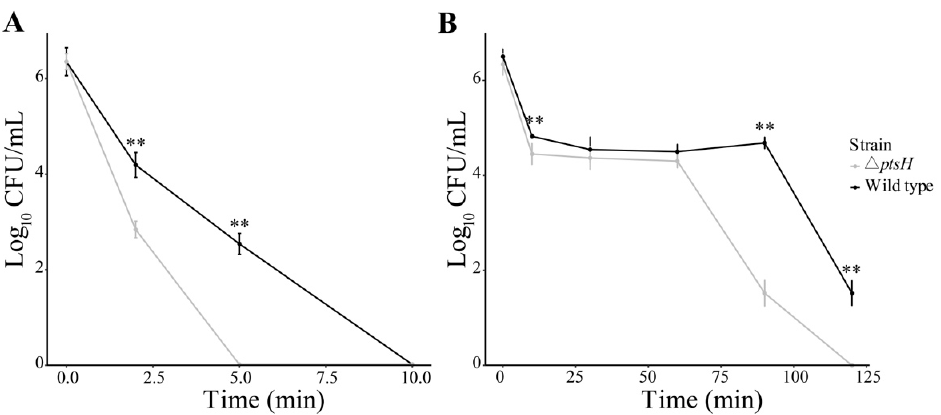
Figure 2. Heat resistance of WT strain and Δ ptsH mutant at 65 °C ( A ) and 55 °C ( B ). Bars represent the standard deviation ( n = 6). ** p < 0.01 compared to the WT strain.